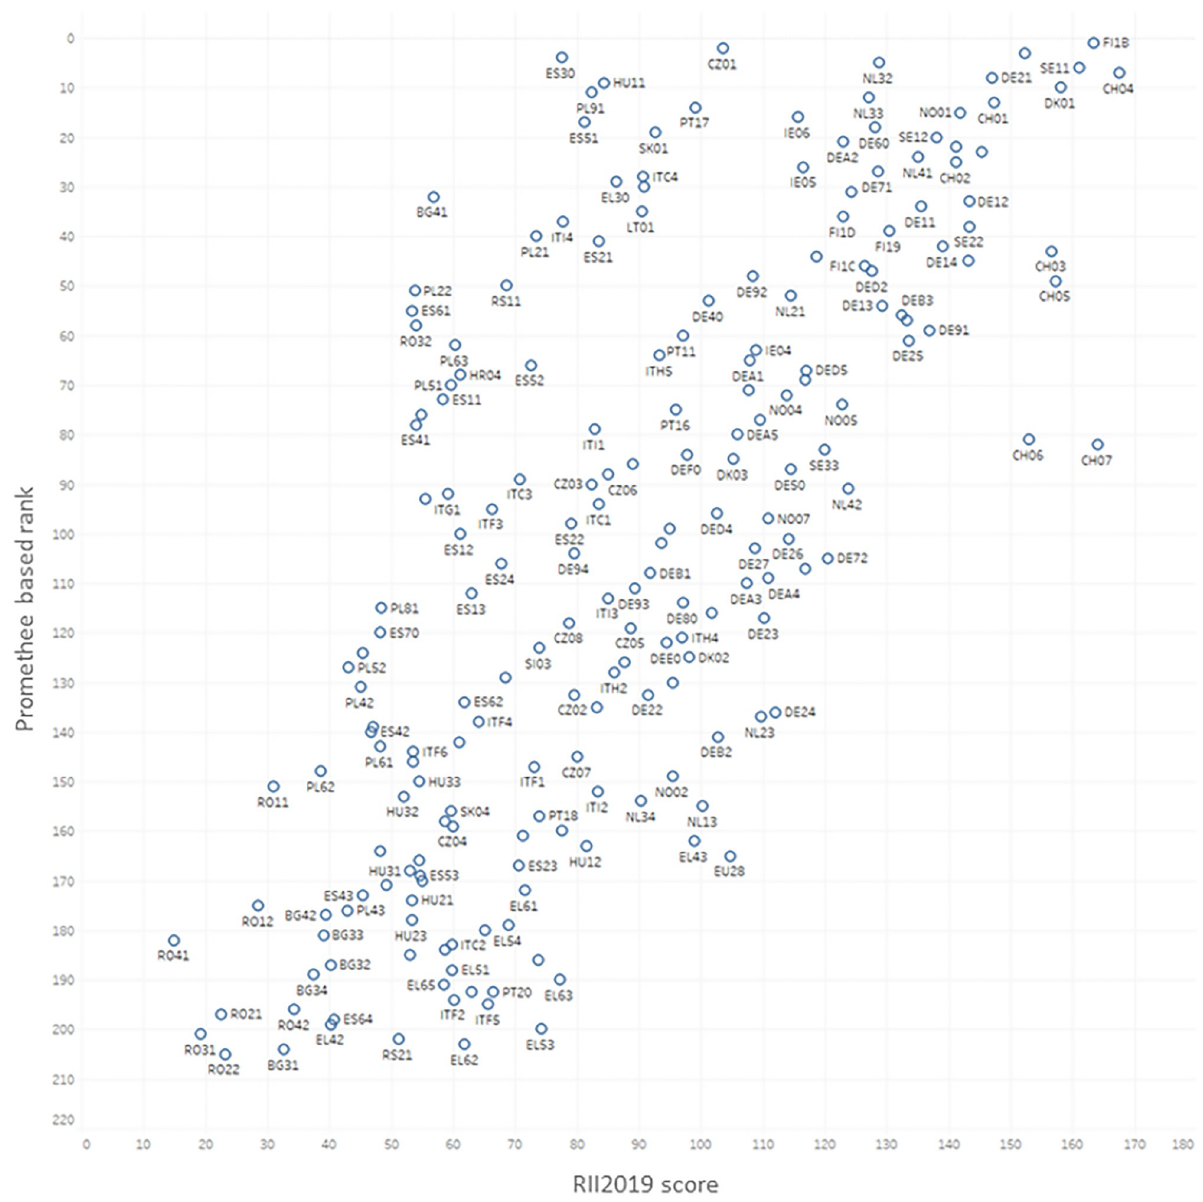
Fig 9. Correlation between the proposed I4.0+ ranking index and the Regional Innovation Index (RII) (r 2 =